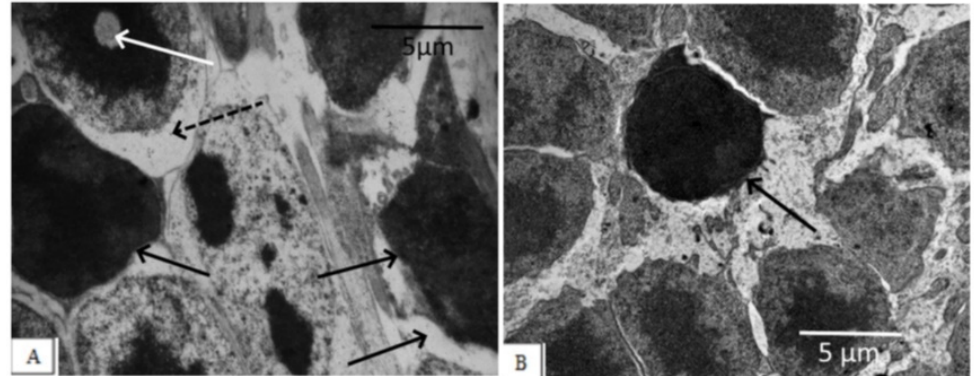
Figure 2. Outer nuclear layer of OXYS rats without correction ( A ) and on the background of IQ ‐ 1S treatment ( B ). In OXYS rats, pronounced changes in the nuclear part of the photoreceptors were observed: nuclear pyknosis (black arrows), perikaryon edema (dashed arrows), and nuclear lysis (white arrow). On the background of treatment with IQ ‐ 1S, the edema phenomena leveled out, a greater preservation of photoreceptor nuclei was observed. However, pyknosis phenomena took place.